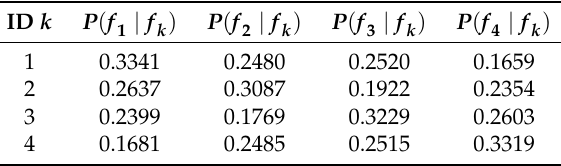
Table 3. Measurement model 2 (range of view : 2.50